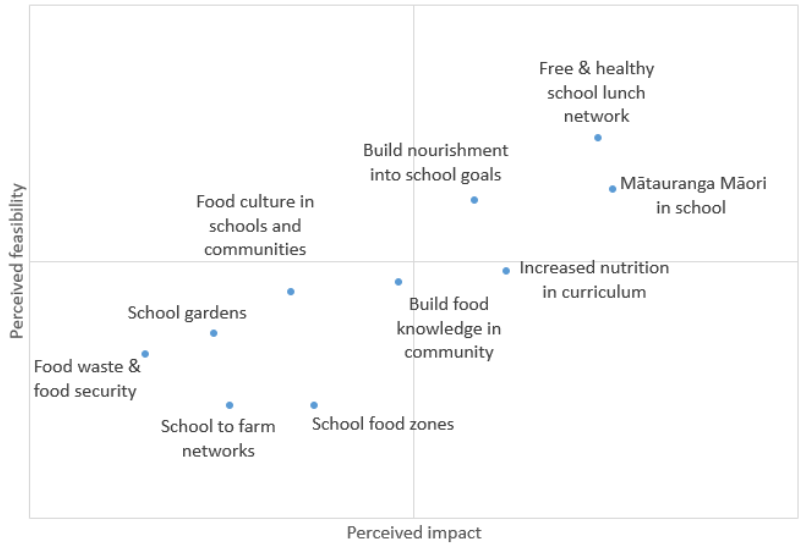
Figure 5. Impact matrix of interventions in the local food system (M ā tauranga M ā ori–Indigenous